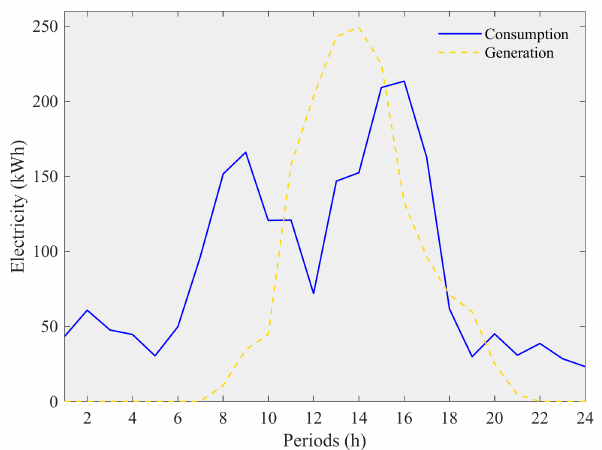
Figure 5. Consumption and generation profile of the energy